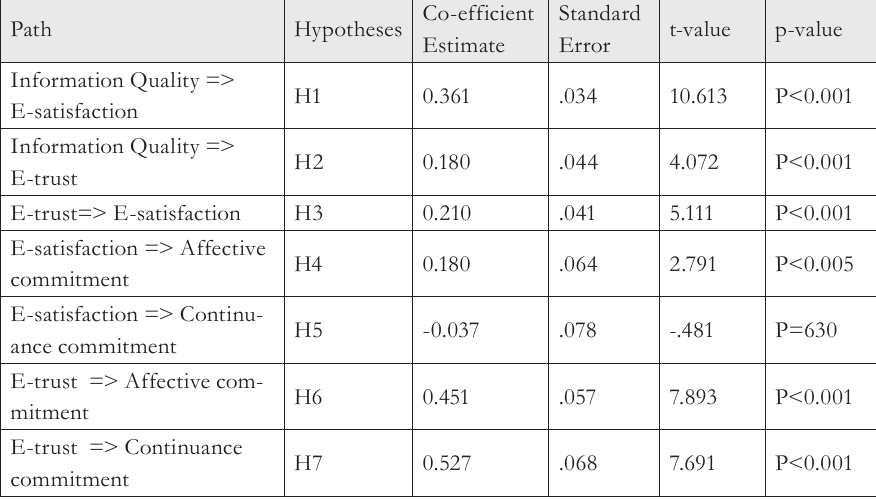
Tab. 6 - Standardized parameter estimates of hypothesized paths. Source: Authors